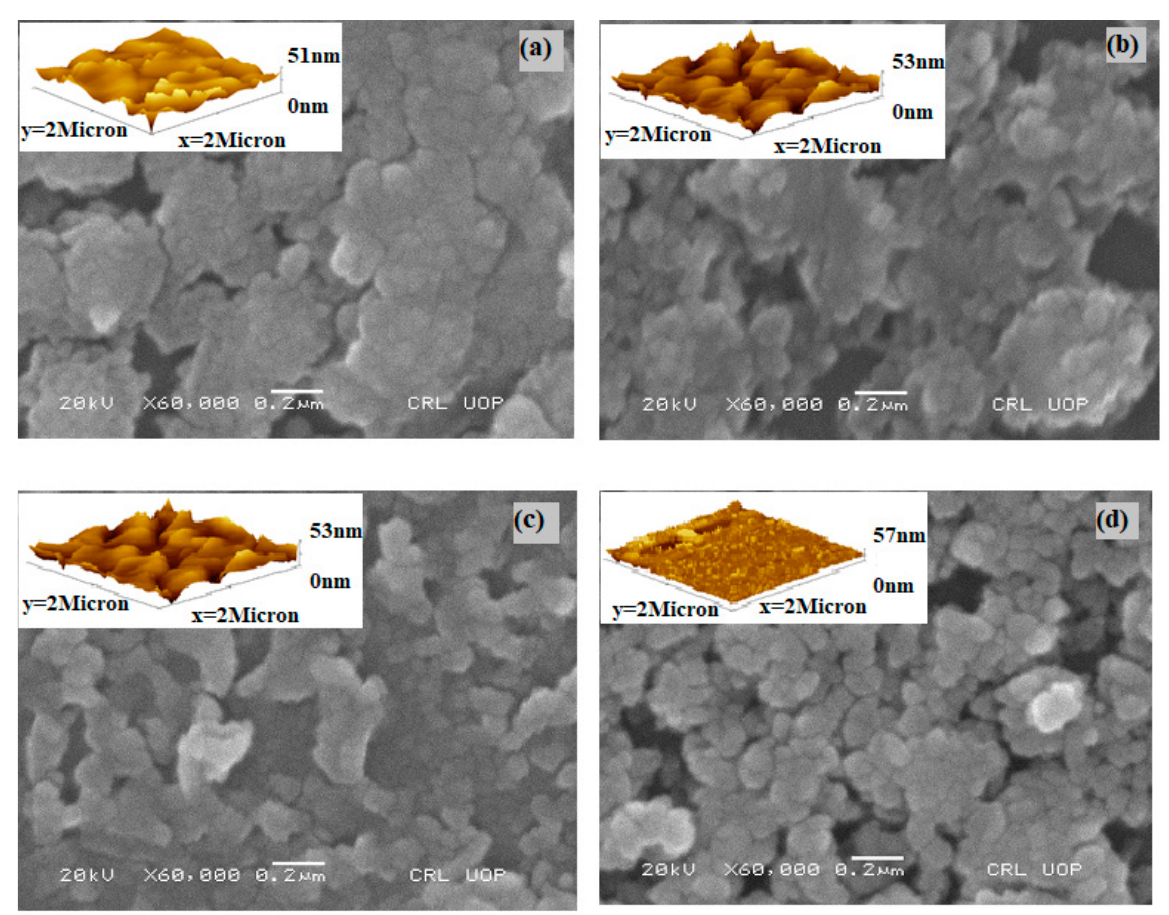
Figure 3. Morphological analysis of ( a ) 1 at.% Cr, ( b ) 1 at.% Cr, ( c ) 2 at.% Cr, and ( d ) 3 at.% Cr doped Bi 2 S 3 with the help of AFM and SEM micrographs.